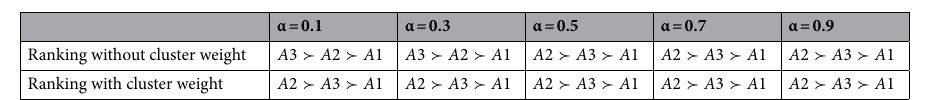
Table 12. Alternative rankings with and without cluster weight considered.